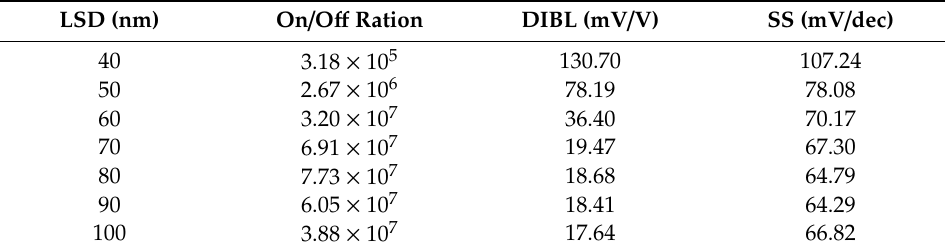
Table 2. Electrical properties of bulk FinFET according to spacer length.